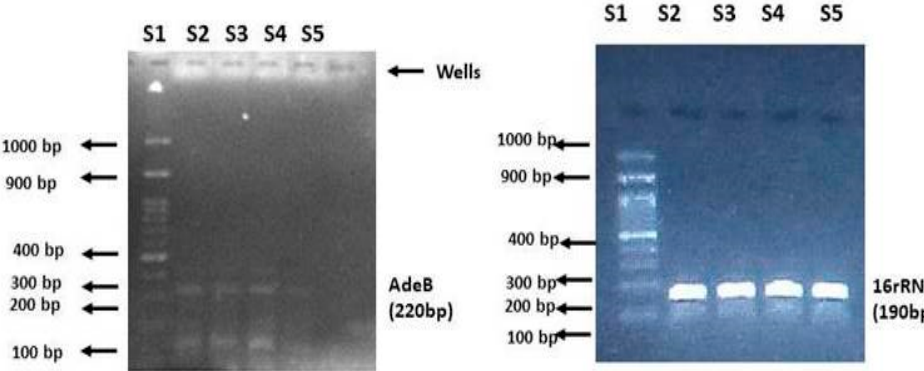
Figure 3. Agarose gel electrophoresis of the treated and untreated AI 7574 isolates. Results of the adeB expression analysis for treated and untreated MDRAb isolates. S1: 100 bp ladder; S: untreated isolates; S3: treated isolates + tigecycline; S4: treated isolates + tigecycline + CCCP; S5: treated isolates + tigecycline + (+)-UA.